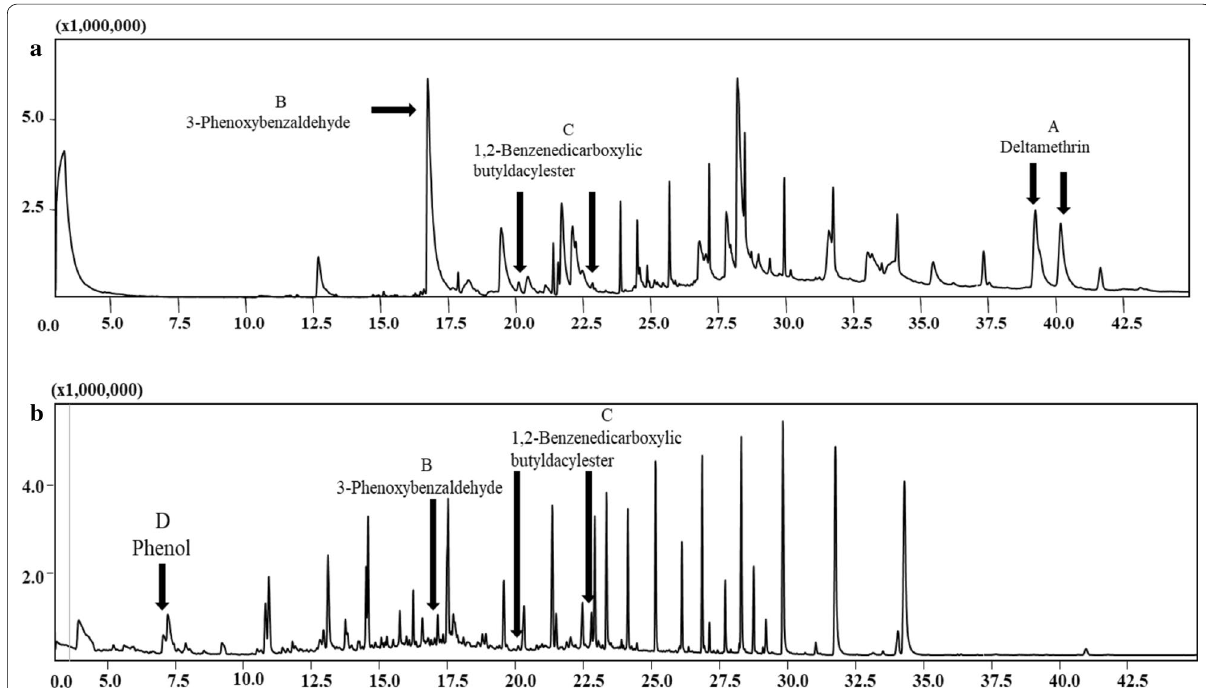
Fig. 4 a GC–MS chromatogram of metabolites of deltamethrin obtained by degradation of deltamethrin in monoculture strain A. junii LH-1-1 within 72 h; and b co-culture strains A. junii LH-1-1 and K. pneumoniae BPBA052 within 72